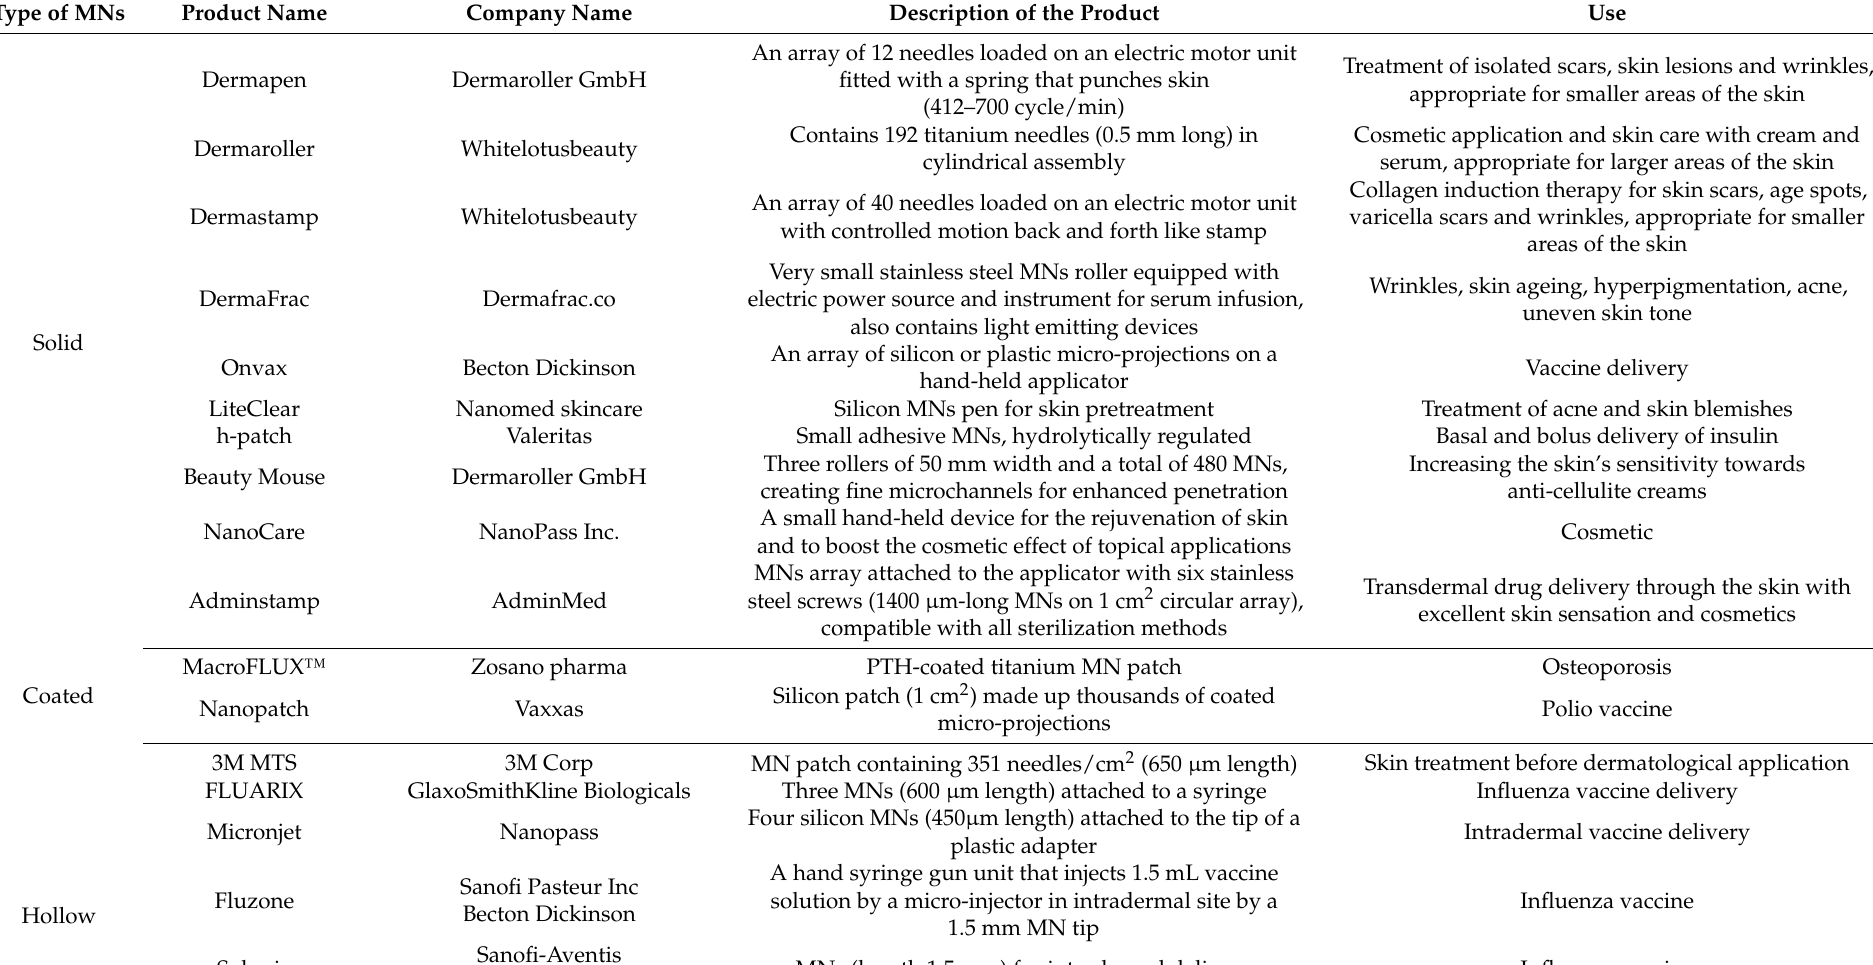
Table 5. Commercially available